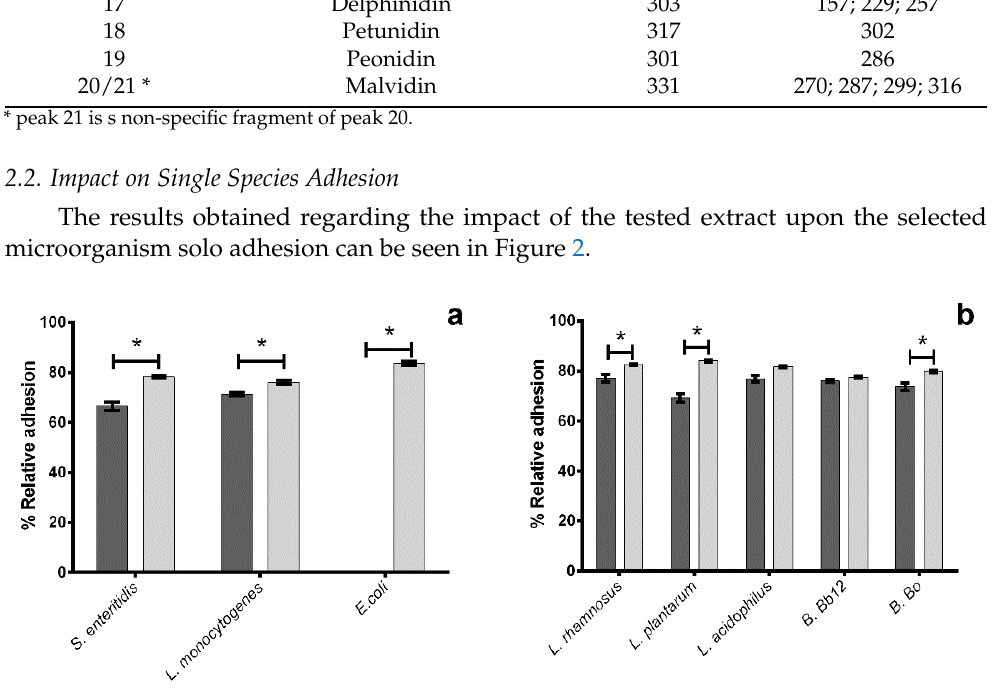
Figure 2. Percentage of relative adhesion of probiotic ( a ) and pathogenic ( b ) bacteria in the presence ( (cid:4) ) and absence ( (cid:4) ) of blueberry extract. The asterisks (*) mark statistically significant differences between sets of data ( p < 0.05).